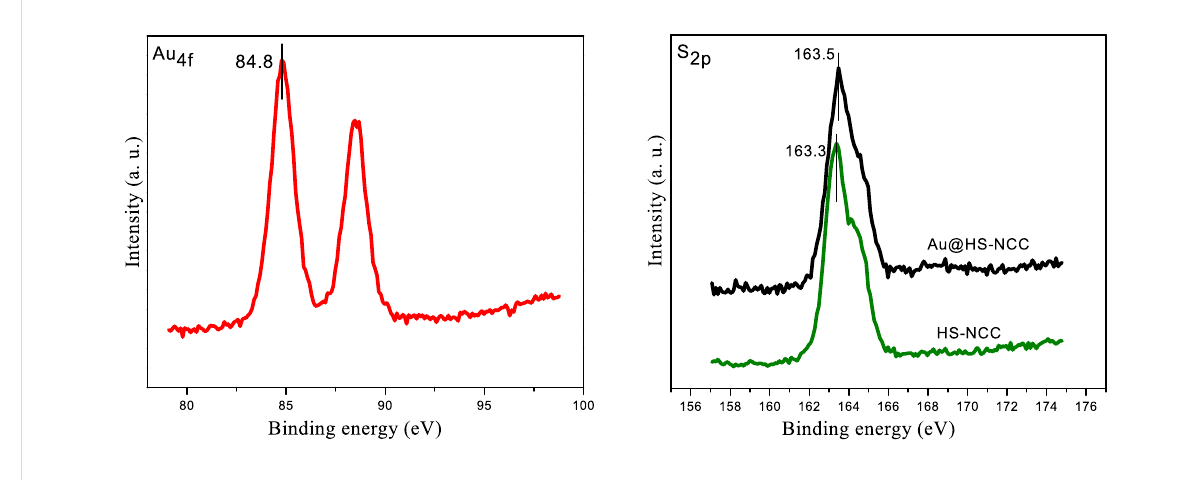
Figure 1: Au 4f and S 2p XPS spectra of the Au@HS-CNC (4.4 mol %) catalyst.